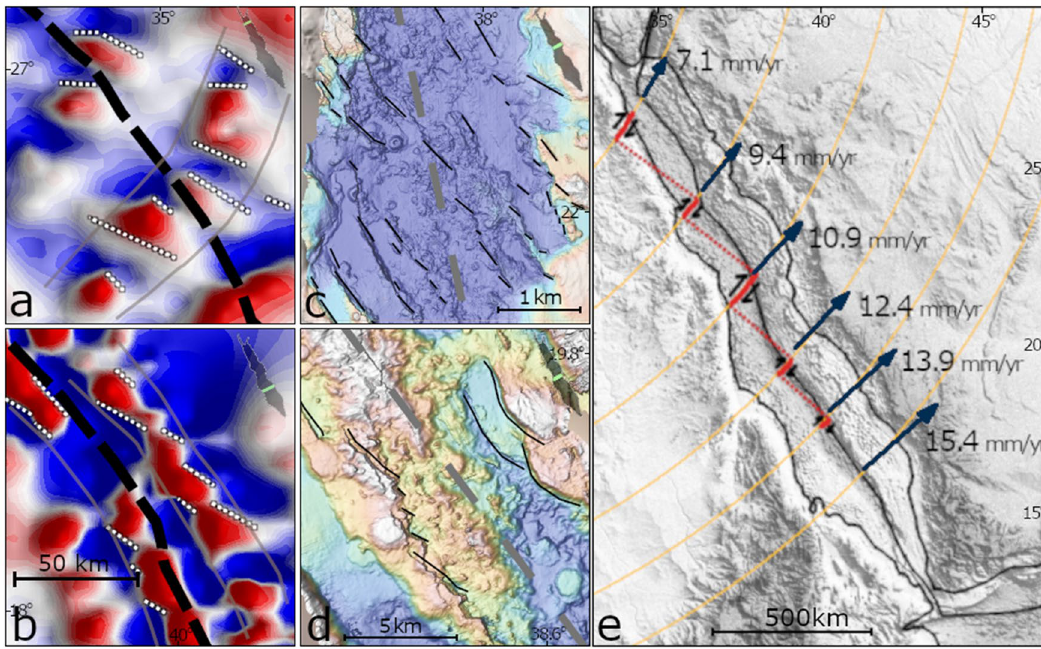
Figure 5. ( a , b ) Two examples of ‘local’ trends of magnetic anomalies from the northern ( a ) and southern ( b ) regions. Patterns of lineated anomalies forming en échelon structures. Black dashed lines mark the Red Sea axis. See Fig. 2 for color bar. ( c , d ) High resolution bathymetry, retrieved from Augustin et al. (2016) 73 showing en échelon structures (black) oblique to the Red Sea axis (grey dashed lines). ( e ) Modeled velocities (blue arrows) along the axis of the Red Sea (after ArRajehi et al., 2010) 49 , and, small circles (yellow) around estimated Euler pole (after Schettino et al., 2016) 18 , suggesting dextral transcurrent flow sub-perpendicular to the rift axis, with a northward increasing shear and